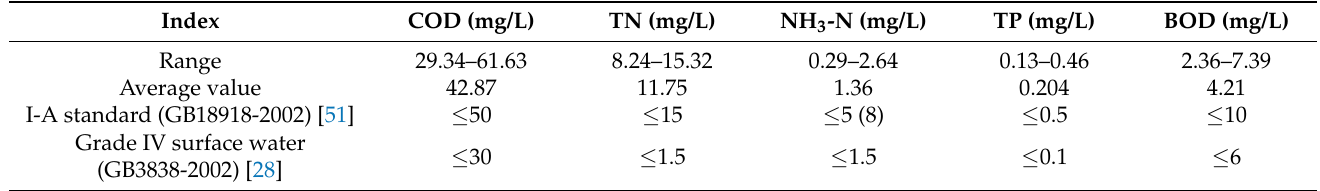
Table 4. The water quality of influent and the standard of water (I-A standard and Grade